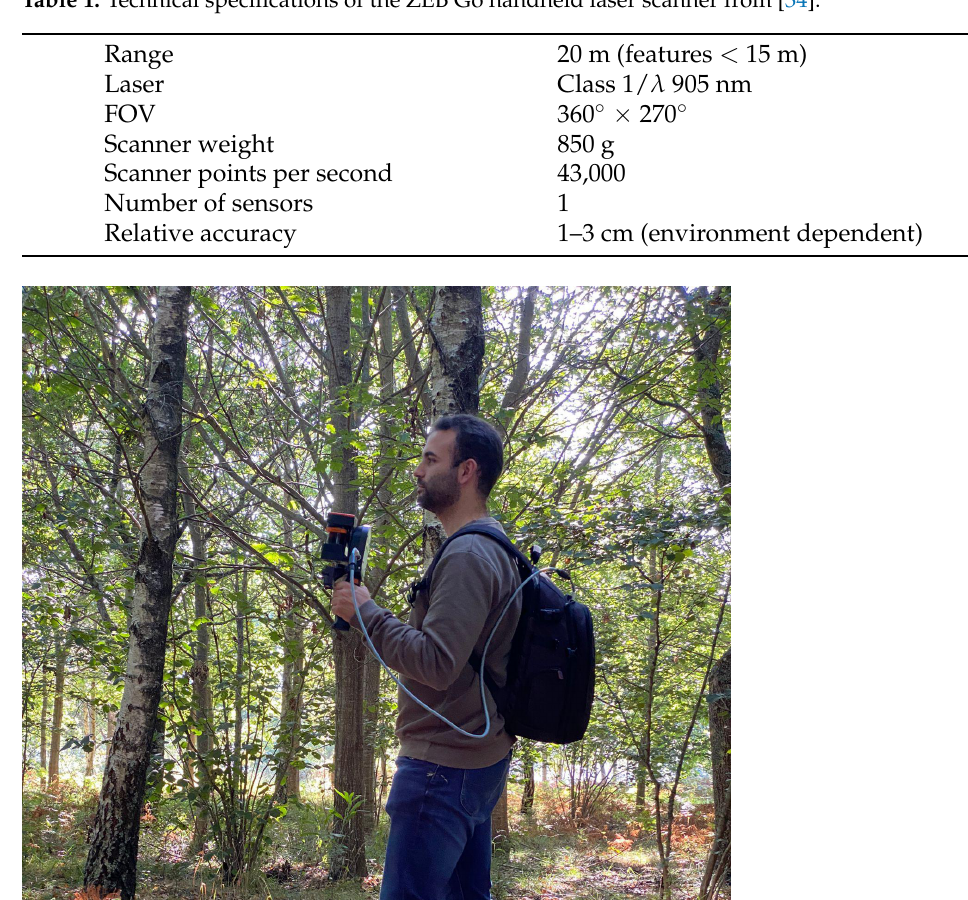
Table 1. Technical specifications of the ZEB Go handheld laser scanner from [34].